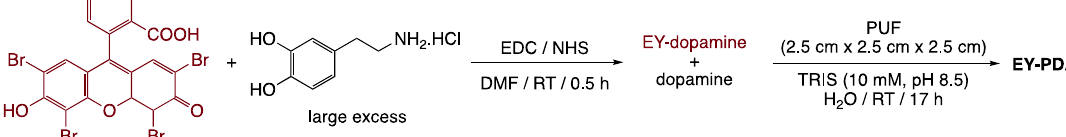
Scheme 1. Hybrid EY-PDA coating a tt empt on PUF.